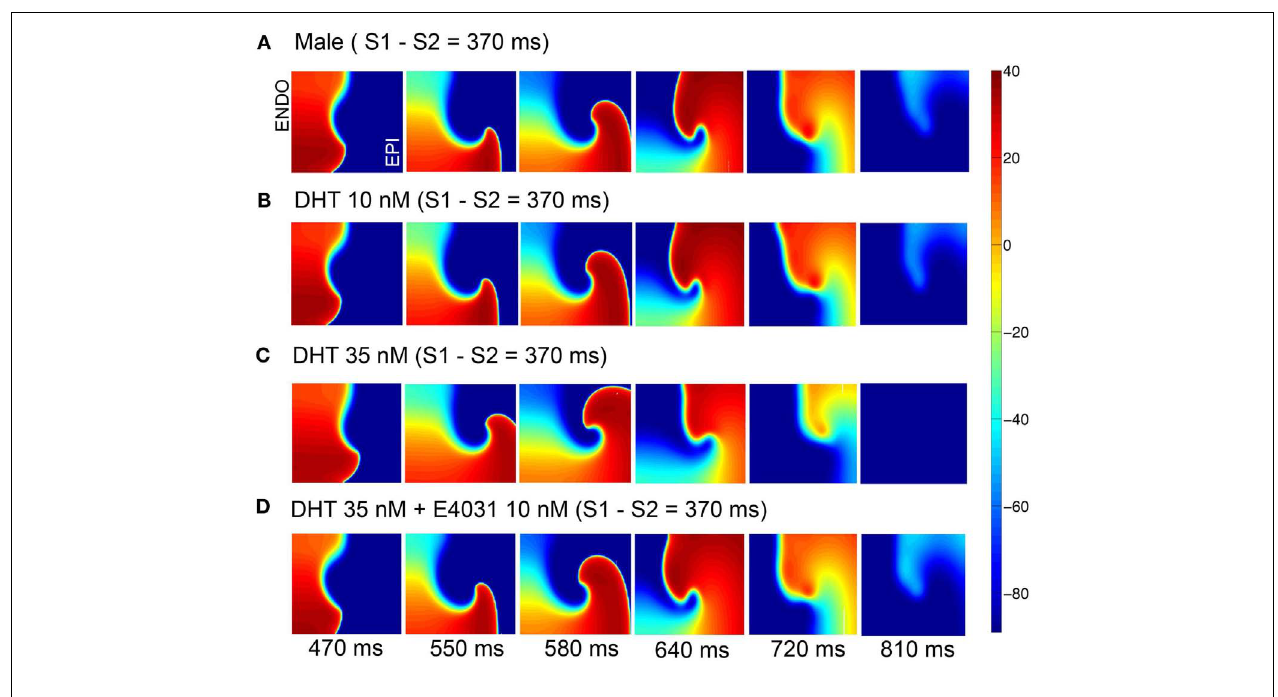
tissue followed by a premature stimulus applied in the endocardial region (see Materials and Methods). Six snapshots following application of DHT and/or drug at indicated time points.Voltages are indicated by the color